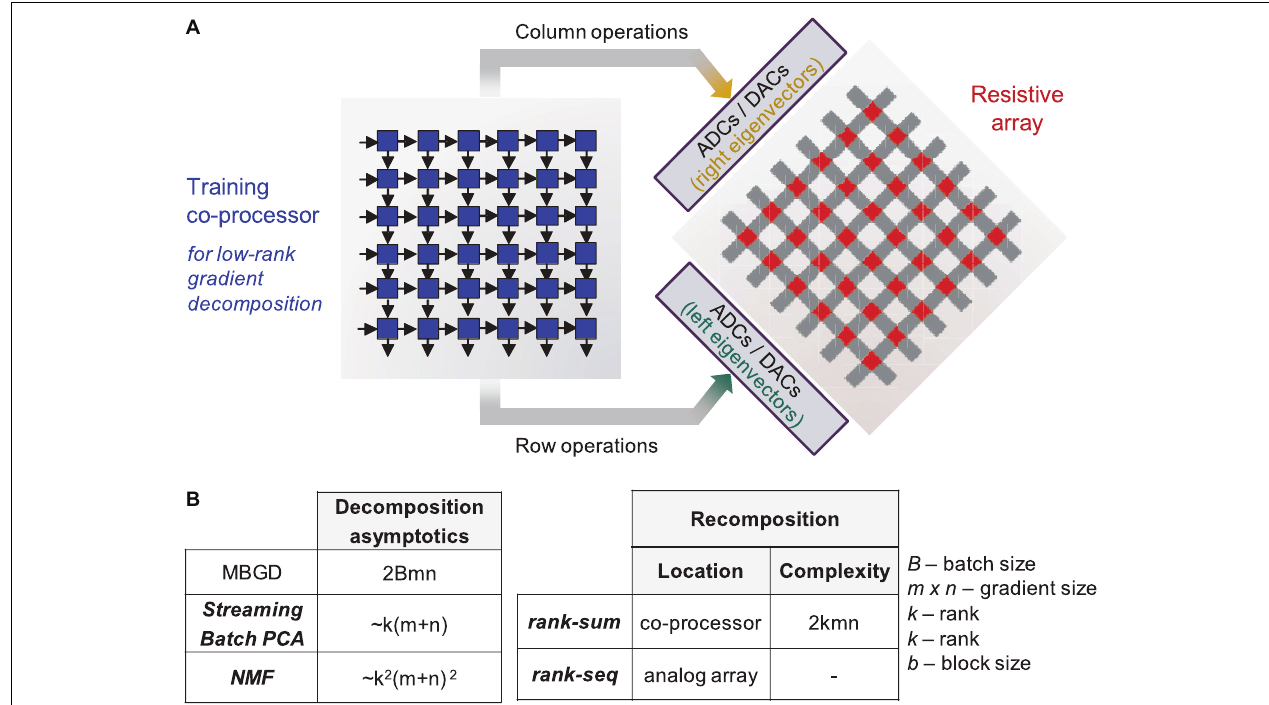
FIGURE 1 | Training co-processor for decomposition. (A) Sketch showing an integrated system – a digital training co-processor will implement the best identified algorithm in an efficient way to support neural network training on non-ideal analog arrays. (B) Computational complexity for Mini-Batch Gradient Descent (MBGD), streaming batch principal component analysis (PCA), and non-negative matrix factorization (NMF), as well recomposition methods – rank summation (rank-sum) vs. rank-by-rank update (rank-seq). The respective eigenvectors are color